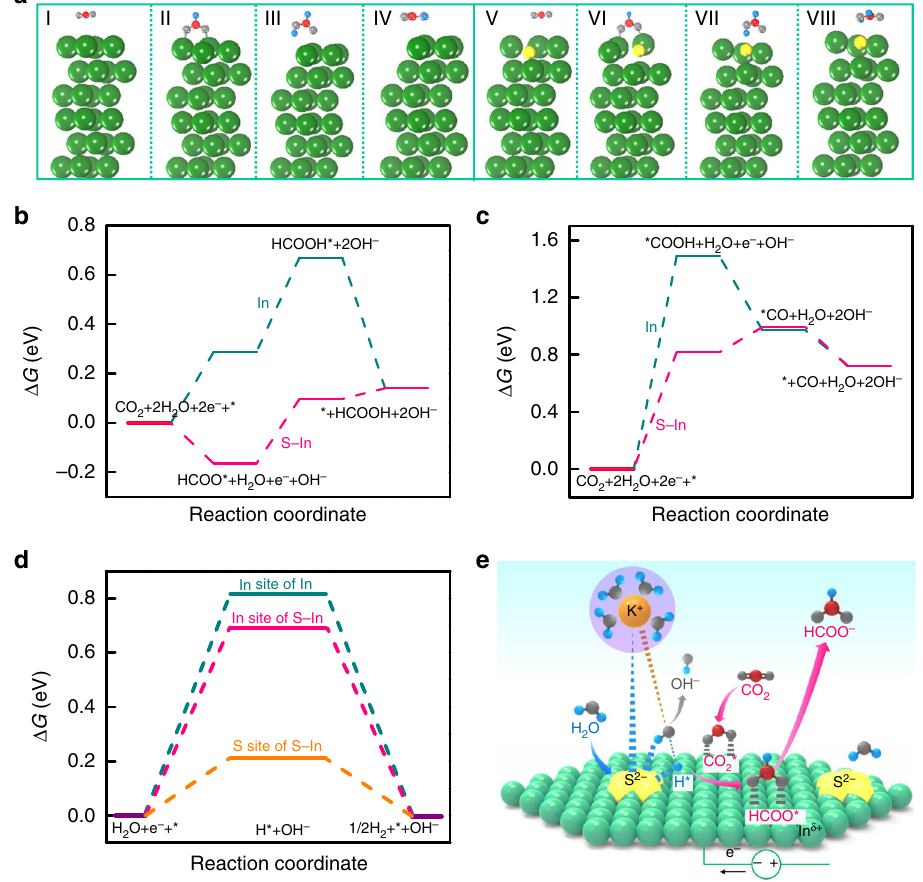
Fig. 3 DFT calculation results and reaction scheme. a Optimized con fi gurations of I CO 2 , II HCOO*, III HCOOH*, IV HCOOH on (101) facet of pure indium (In) and V CO 2 , VI HCOO*, VII HCOOH*, VIII HCOOH on (101) facet sulfur-doped indium (S – In). b Gibbs free energy diagrams for CO 2 RR to HCOOH on In (101) and S − In (101) surfaces. c Gibbs free energy diagrams for CO 2 RR to CO on In (101) and S − In (101) surfaces. d Gibbs free energies for the formation of H* on pure In (101), In and S sites of S − In (101) surfaces. e Schematic illustration for the role of S 2 − in promoting water dissociation and H* formation for the reduction of CO 2 to formate. Free energies of b , c and d are shown relative to gas CO 2 and H 2 . The green, yellow, gray, red, and blue balls represent In, S, O, C, and